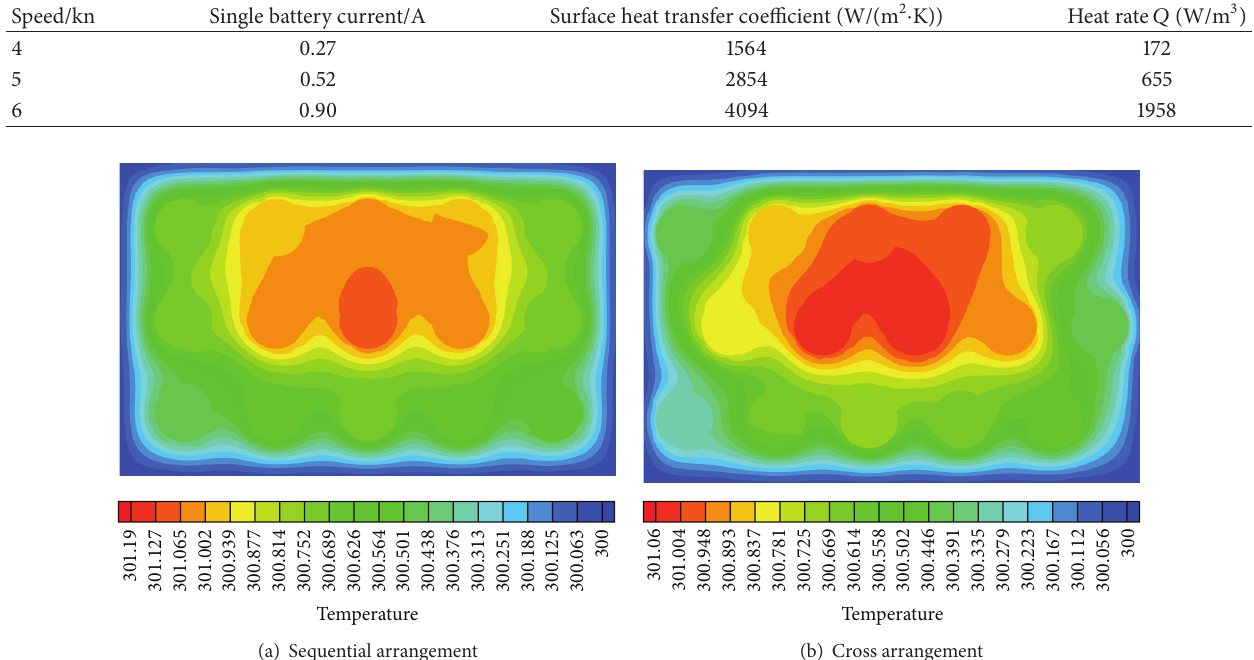
Figure 4: Simulation results of sequential arrangement and cross arrangement.